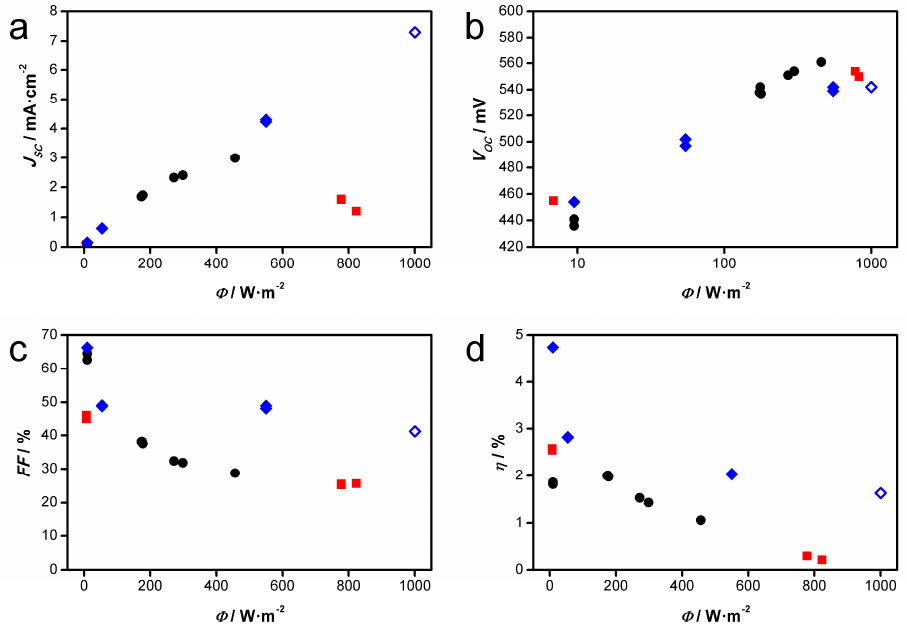
Figure 8. Dependence of photovoltaic parameters on light intensity ϕ . ( ■ ) Flexible DSSC module “1”. ( ● ) Flexible DSSC module “2”. ( ♦ ) Flexible small-scaled DSSC. Open symbol: Measurement performed in solar simulator. All other measurements were performed under real sunlight. ( a ) short circuit current J SC ; ( b ) open circuit voltage V OC ; ( c ) fill factor (FF); ( d ) power conversion efficiency η .